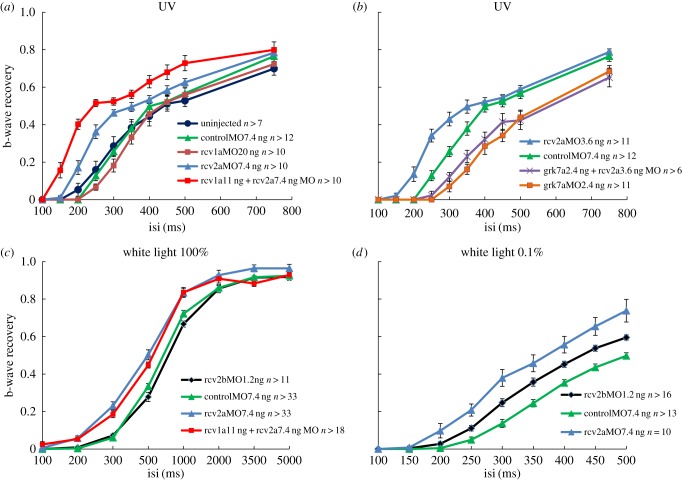
Cone photoresponse recovery is accelerated in Rcv-deficient larvae. Time course of b-wave recovery in (a,b) UV spectral ERG, (c) maximum white light ERG and (d) dim white light ERG are shown. Under UV light conditions recoverin2a and combination of recoverin1a and recoverin2a are effective in accelerating the response recovery (a), whereas depleting the effort kinase Grk7a as expected prolongs the recovery time (b). Note that Rcv2a knockdown accelerates response recovery under normal and dim white light conditions, whereas Rcv2b only accelerates recovery under dim light conditions (c,d). Data are presented as mean ± s.e.m.